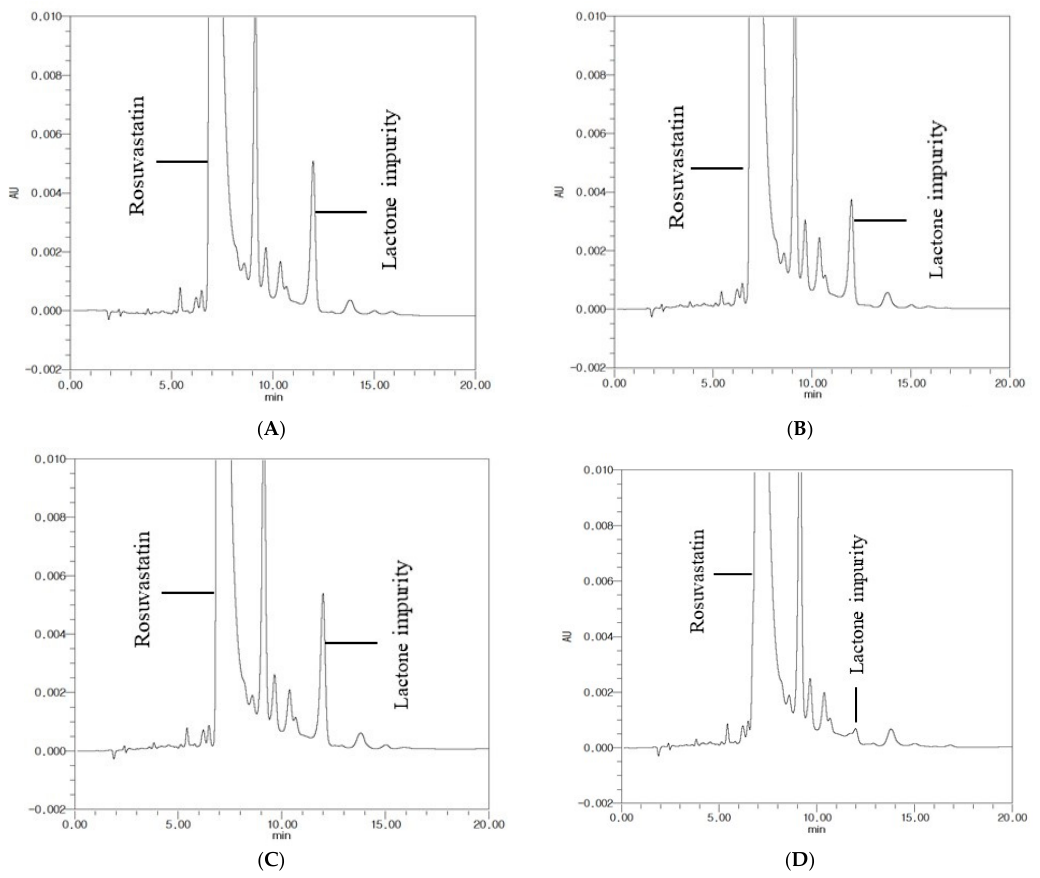
Figure 3. Chromatograms obtained from different formulations after four months of storage at 40 °C/RH 75%. ( A ) Hypromellose, ( B ) carnauba wax, ( C ) sodium stearyl fumarate, and ( D ) glyceryl behenate.